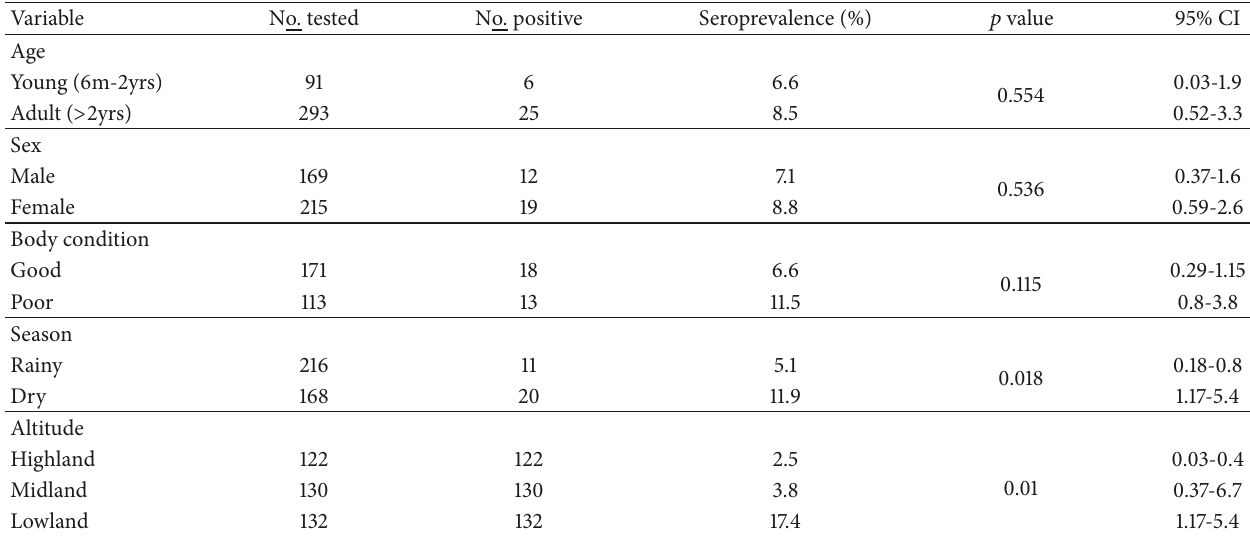
Table 2: Effect of risk factors on seroprevalence of CBPP tested by X 2